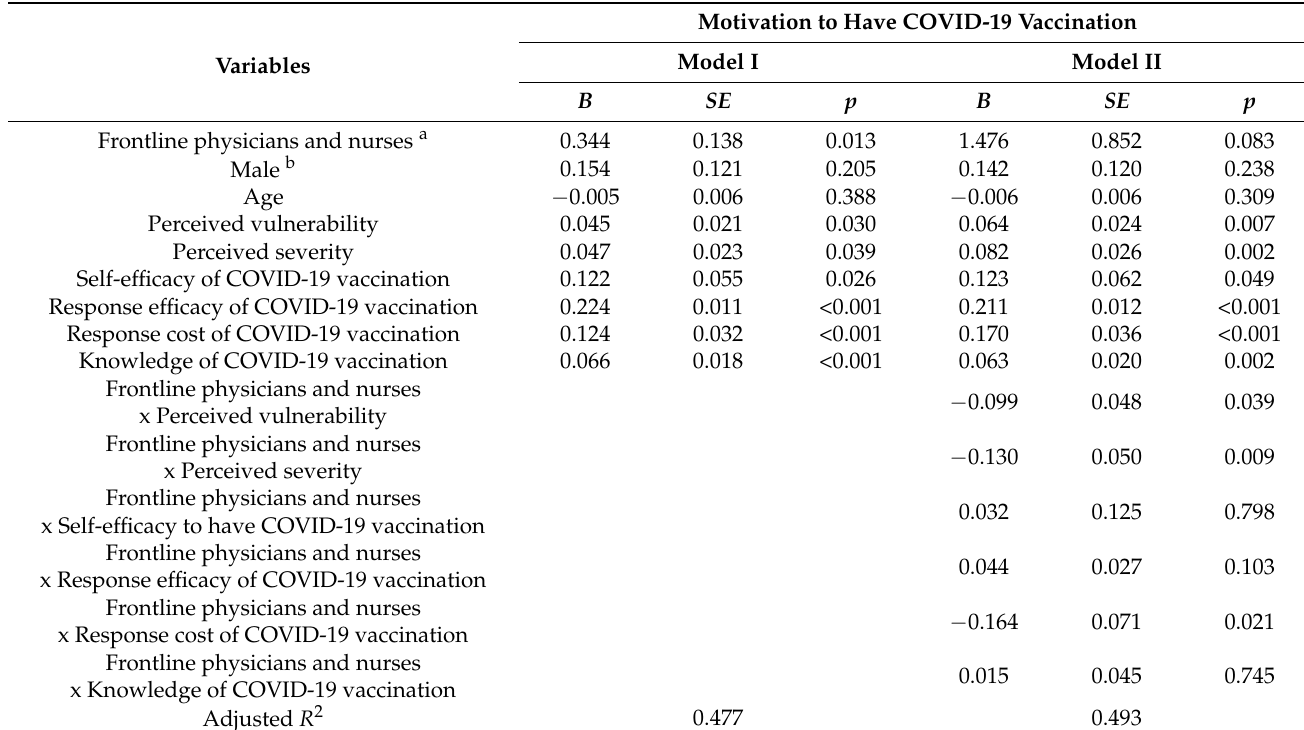
Table 3. Factors Related to Motivation to Receive COVID-19 Vaccination: Multiple Regression Analysis.